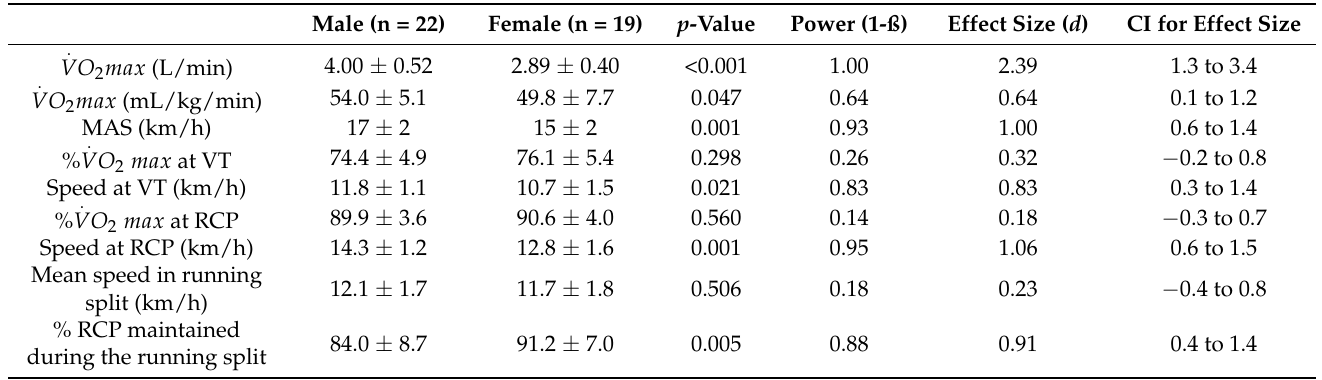
Table 1. Comparison between sexes of the descriptive characteristics of